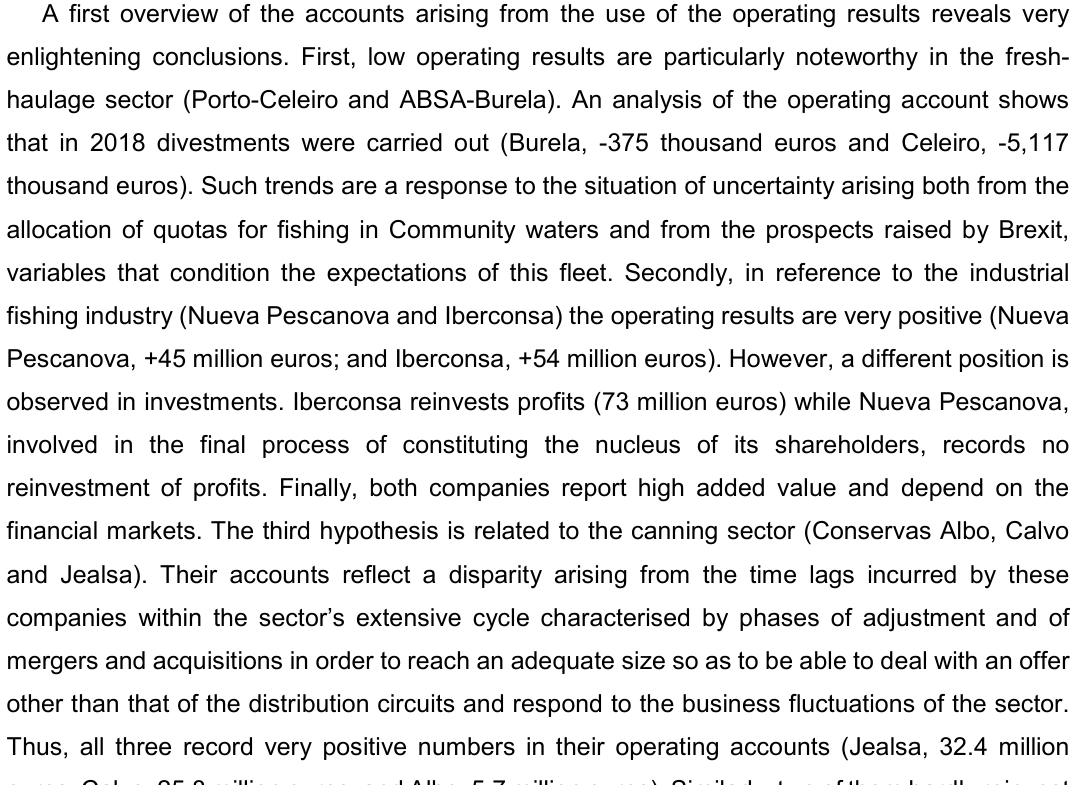
Nueva Canning Pescanova Albo Iberconsa